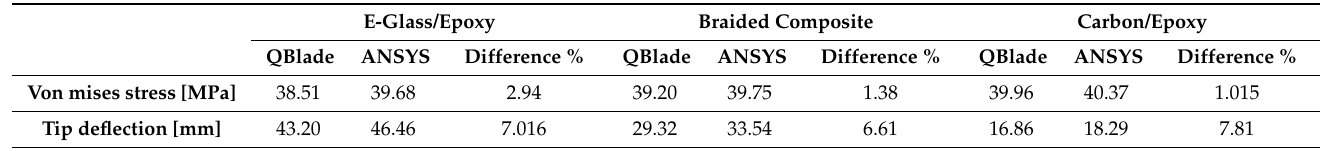
Table 6. The tip deflections and von mises stress using different